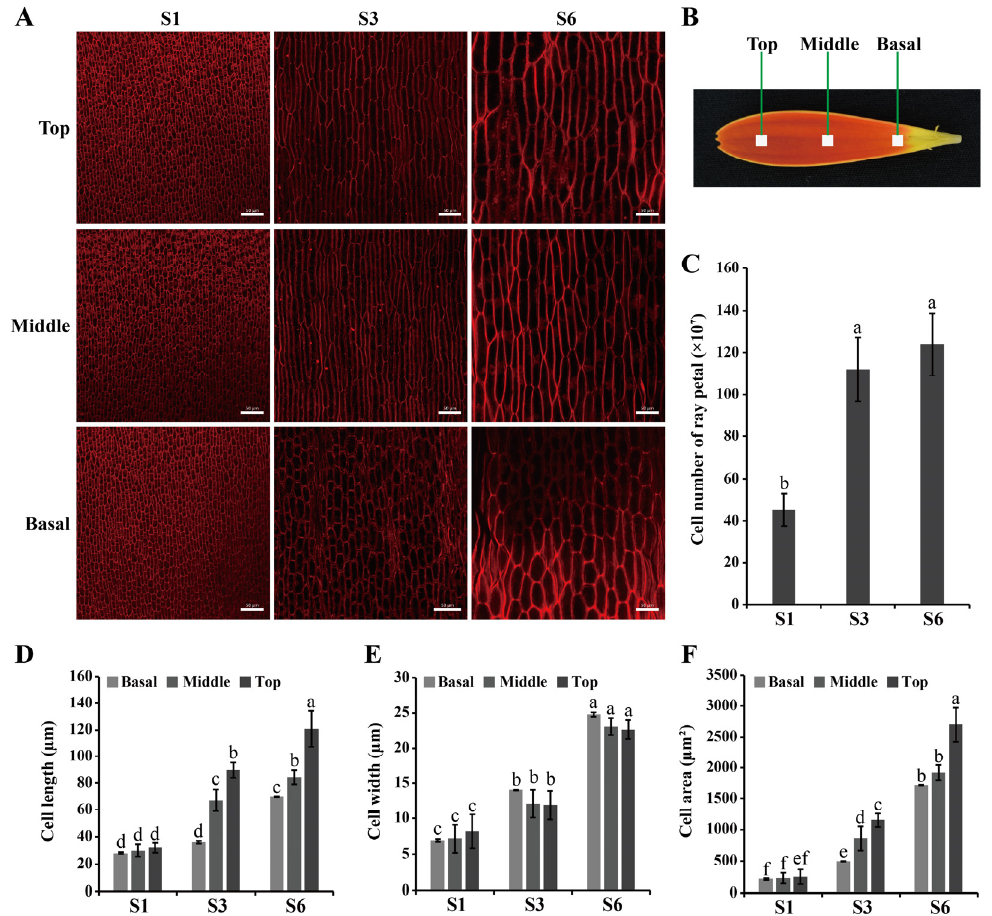
Figure 2. Comparison of cell size, cell number and cell area in each region of developing ray petals. ( A ) Morphological characterization of petal cells. Scale bar = 50 μ m. ( B ) Blocks (1 mm 2 ) at the center of the basal, middle or top regions of the ray florets were sampled for morphological characterization of petal cells. ( C ) Cell number of ray petals. ( D – F ), The cell length ( D ), cell width ( E ) and cell area ( F ) in each region of ray petals at different stages. Statistical significance is indicated by different letters ( p < 0.05). Values represent means of n = 3 ± SD.